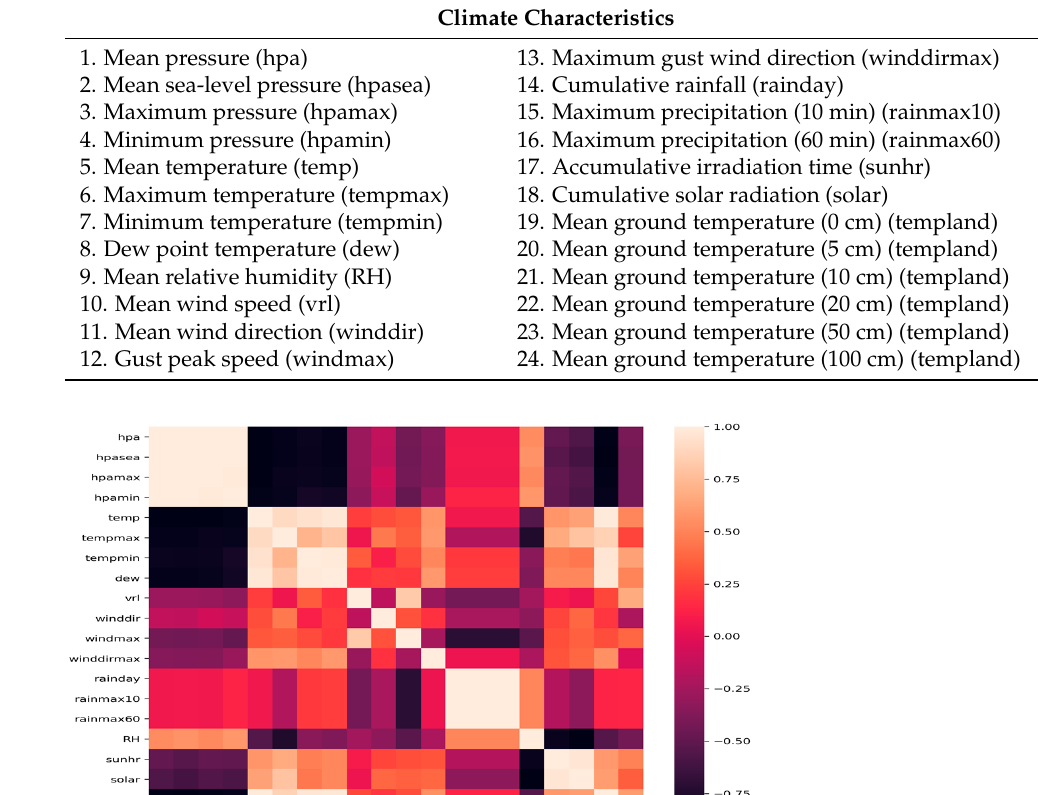
Table 1. Climate characteristics used in Experiment 1.